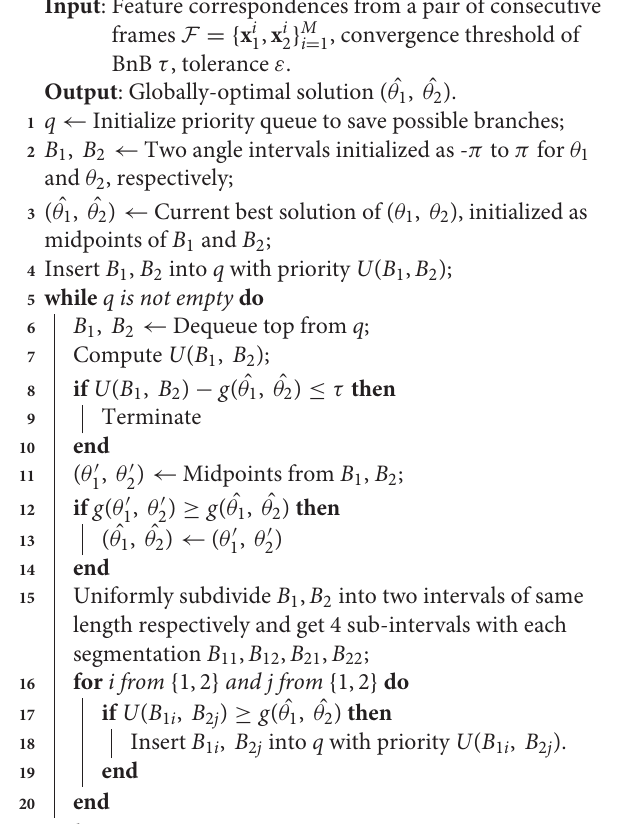
Algorithm 1: BnB for relative pose estimation from consecutive